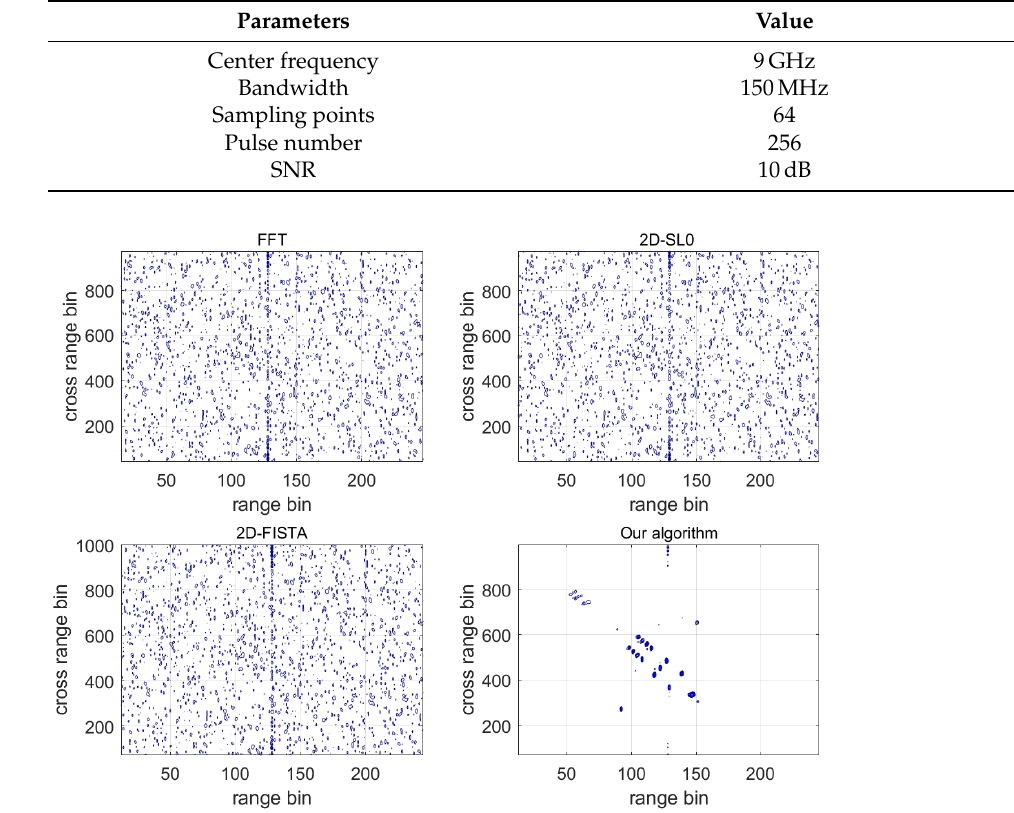
Table 3. The parameters of the step radar.